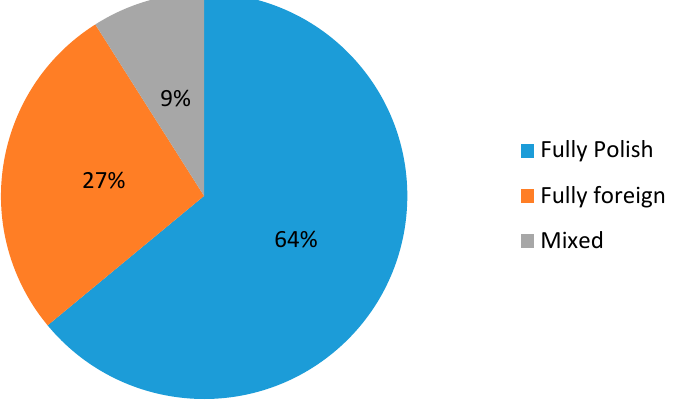
Figure 5. Objectives of forming strategic alliances as declared by Polish firms.